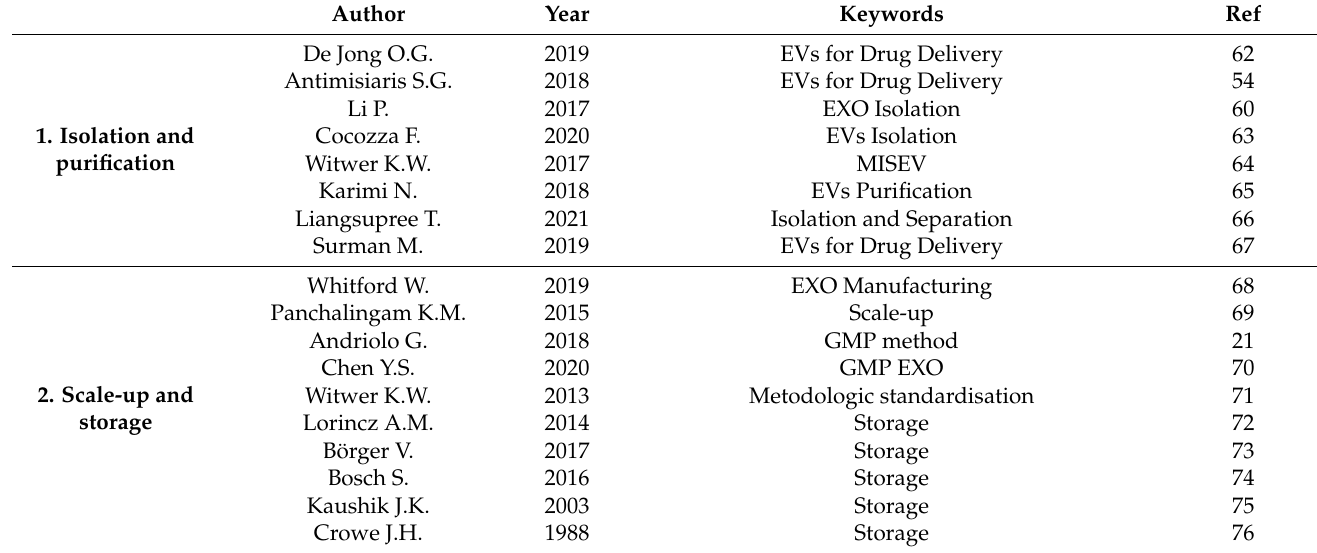
Table 2. Isolation and purification scale-up and storage cargo loading, EV targeting, and cargo delivery strategies for extracellular vesicle-mediated drug